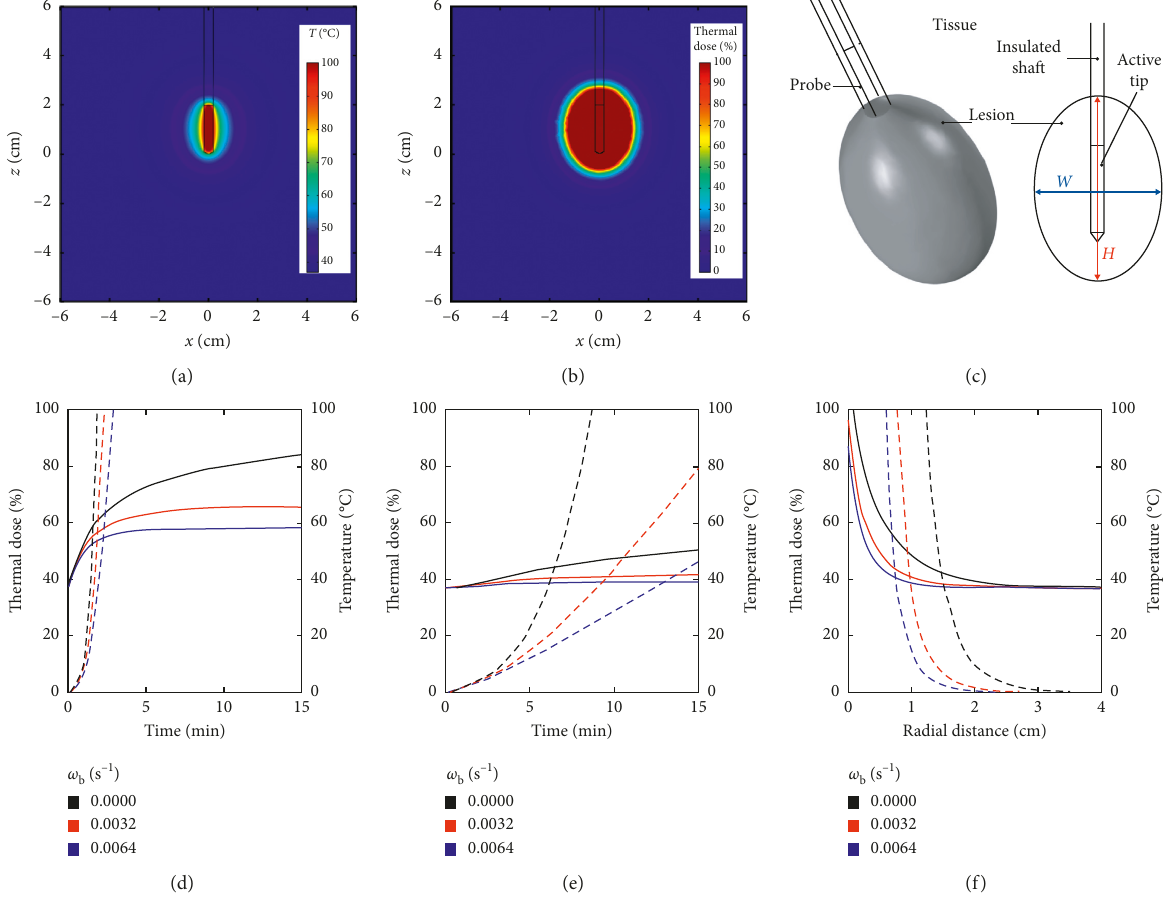
Figure 3: Cross-sectional ( x - z plane) (a) temperature distribution and (b) thermal damage on the central slice. (c) A schematic of the lesion and the measured parameters. Tissue temperature (solid lines) and thermal damage (broken lines) at a distance of (d) 0.3cm and (e) 1cm from the outer surface of the active tip as a function of time. (f) Tissue temperature (solid lines) and thermal damage (broken lines) measured from the surface of the active tip. Study settings: t Table 2: Temperature predictions for a range of AMF amplitudes (5–15kA Domain ϕ (vol.